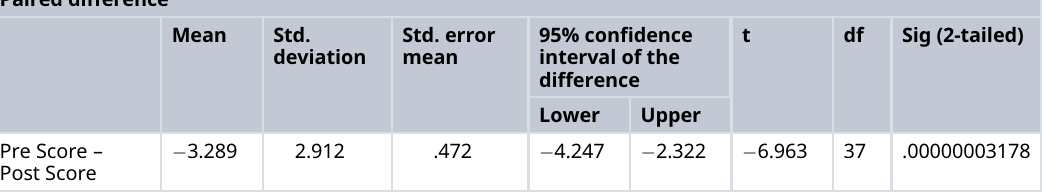
Table 8. Paired-samples T test. Paired